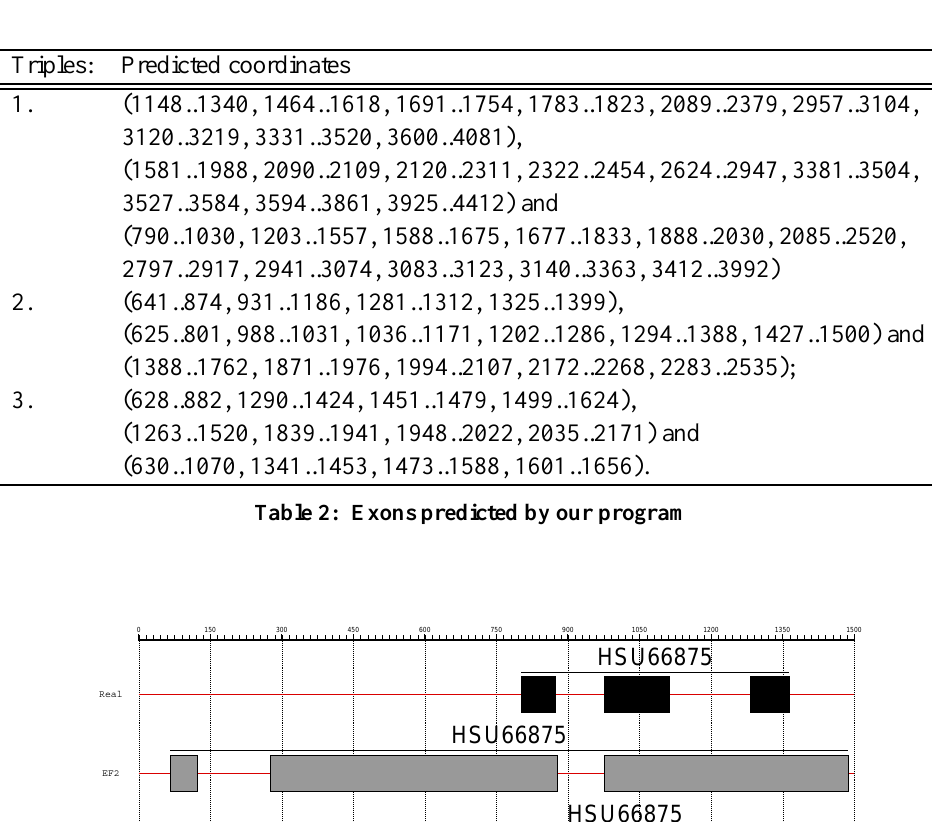
Table 1: Triples used in testing our program.